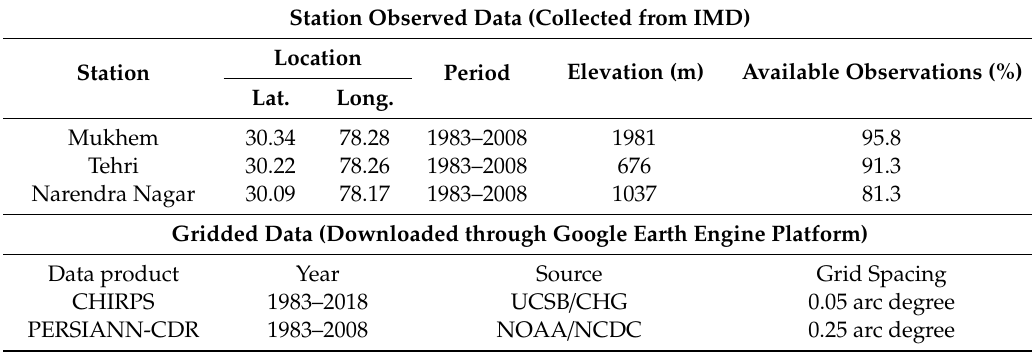
Table 1. Data used to estimate long-term rainfall variability in the Bhilangana river